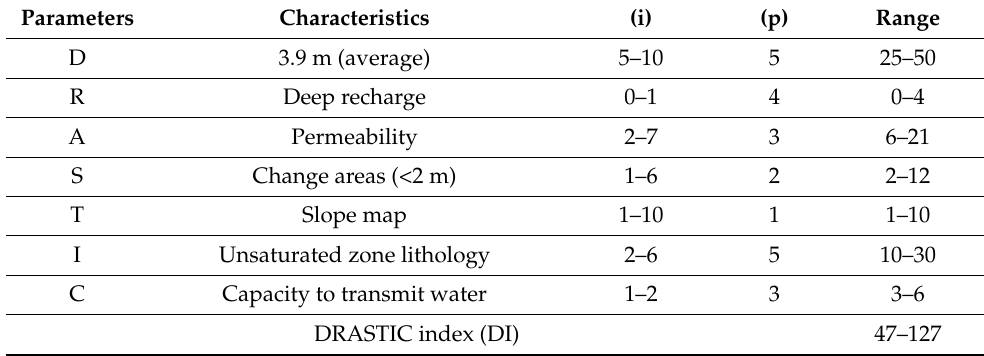
Table 3. Values and weights used for calculating the DRASTIC